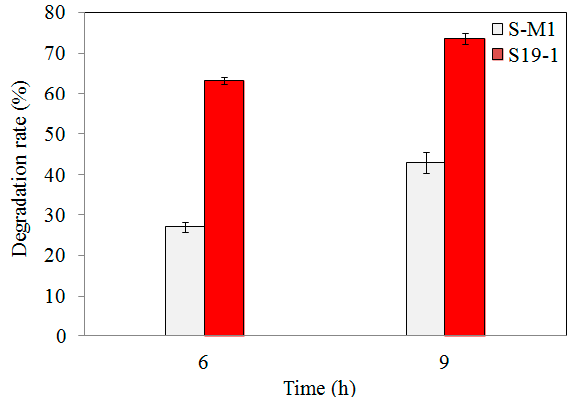
Figure 2. TNT degradation by wild-type S19-1 (red) and the S-M1 (grey) mutant strain. TNT degradation was followed for 6 h or 9 h, respectively. Data are presented as mean of N = 4, x ± SD. Statistical significance is denoted as p < 0.05 using SPSS.